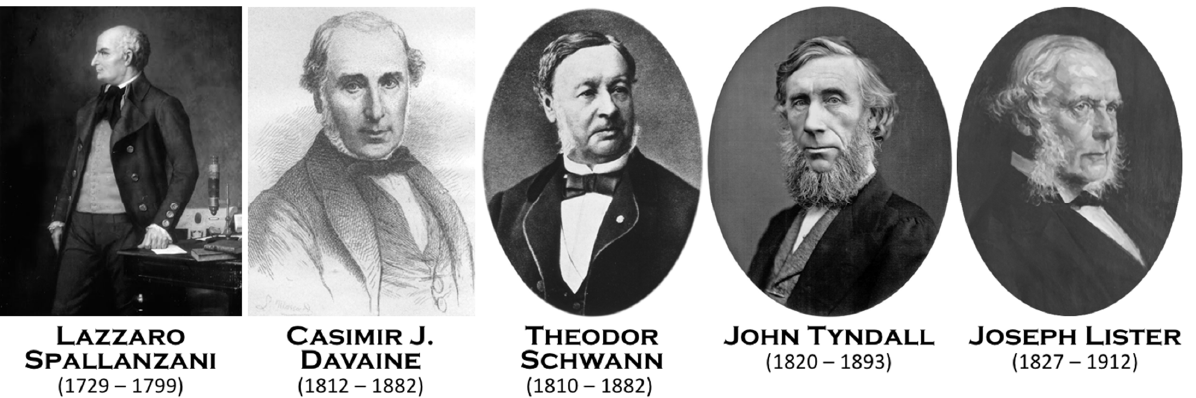
Figure 2. The main predecessors recognized by Louis Pasteur (Spallanzani, Davaine, and